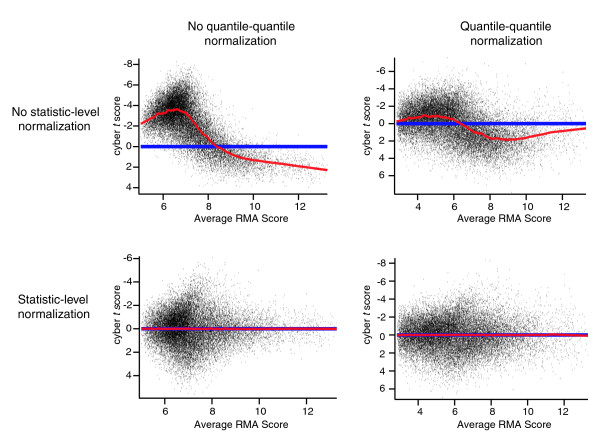
Fitting data to a local regression removes systematic variations present after quantile-quantile normalization. Shown is a comparison of cyber t scores for the null genes of the Latin Square comparison of experiment 8 versus 9 in the presence and absence of quantile-quantile and statistics level normalization (see text). Red lines are Lowess regression lines with a window size of 1,000.